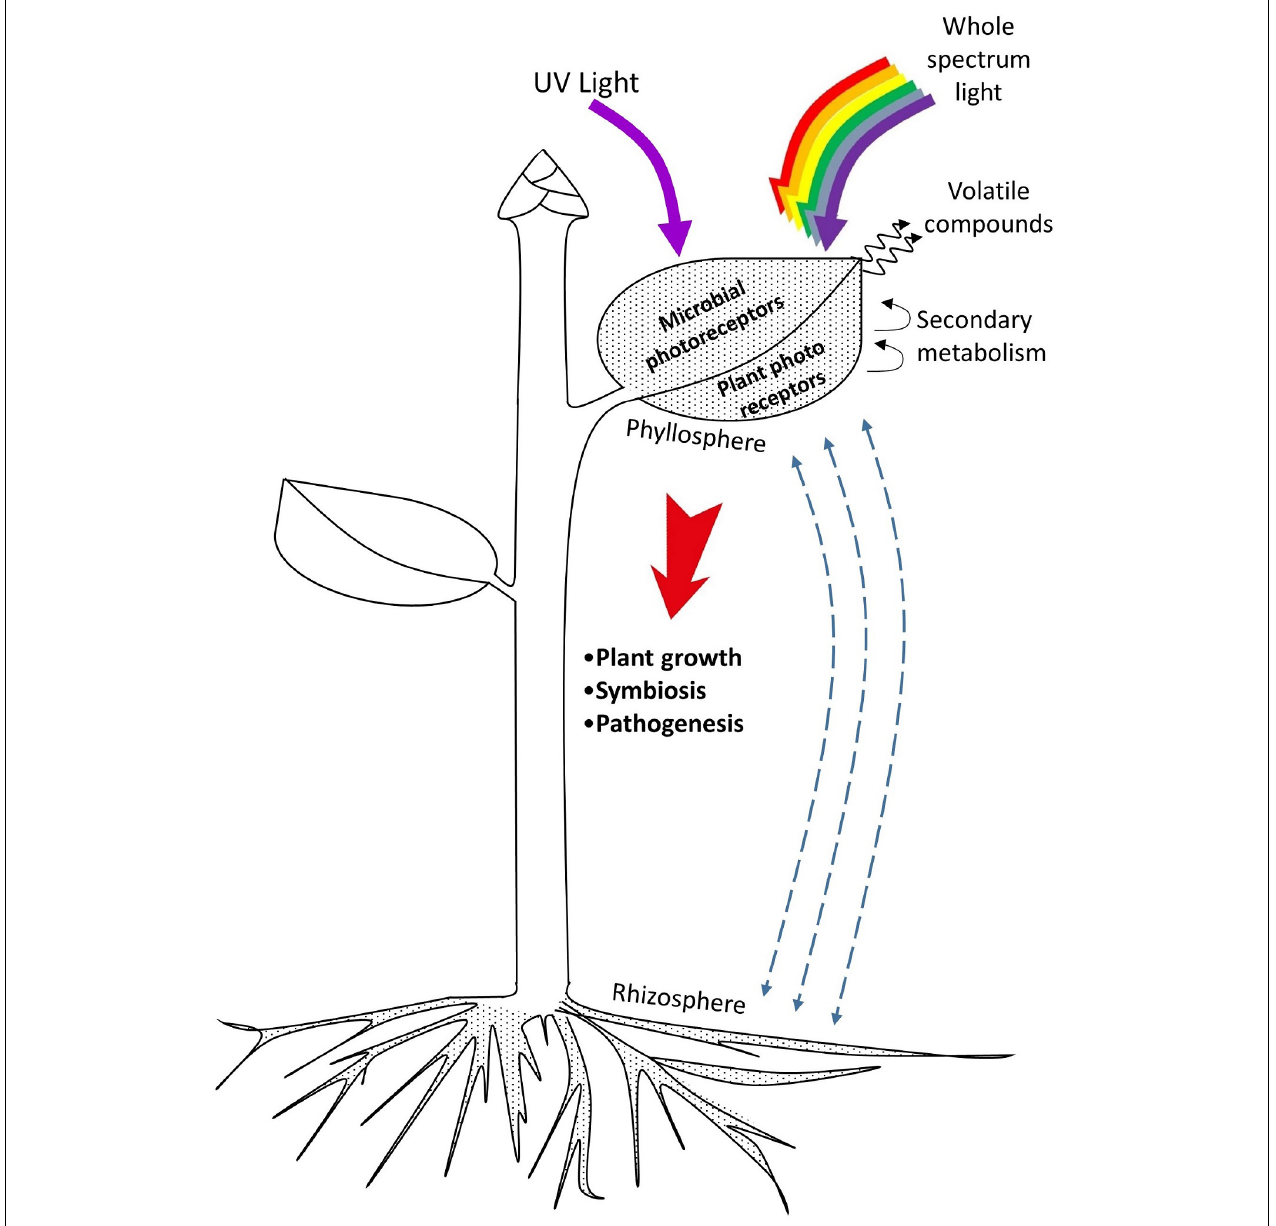
FIGURE 1 | Plant–phyllosphere interactions influenced by light. Microbial residents of leaves and other aerial plant organs interact with rhizosphere microorganisms by exchanging individuals and other compounds. Both plant and microbial photoreceptors capture UV and other components of the light spectrum to perform a variety of metabolic functions. Close interactions between plants and microorganisms are mediated by molecules from primary and secondary metabolism produced by plants, and by important organic-type elements and plant growth regulators released by microorganisms. These interactions ultimately define plant growth and